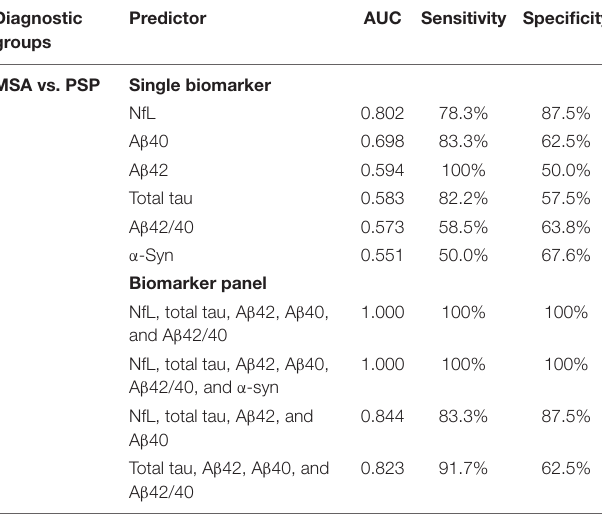
TABLE 3 | Discriminatory value of plasma NfL, total tau, A β 42, A β 40, A β 42/40 and α -syn as a single biomarker and as part of plasma biomarker panel in differentiating PD from APD (MSA and PSP).